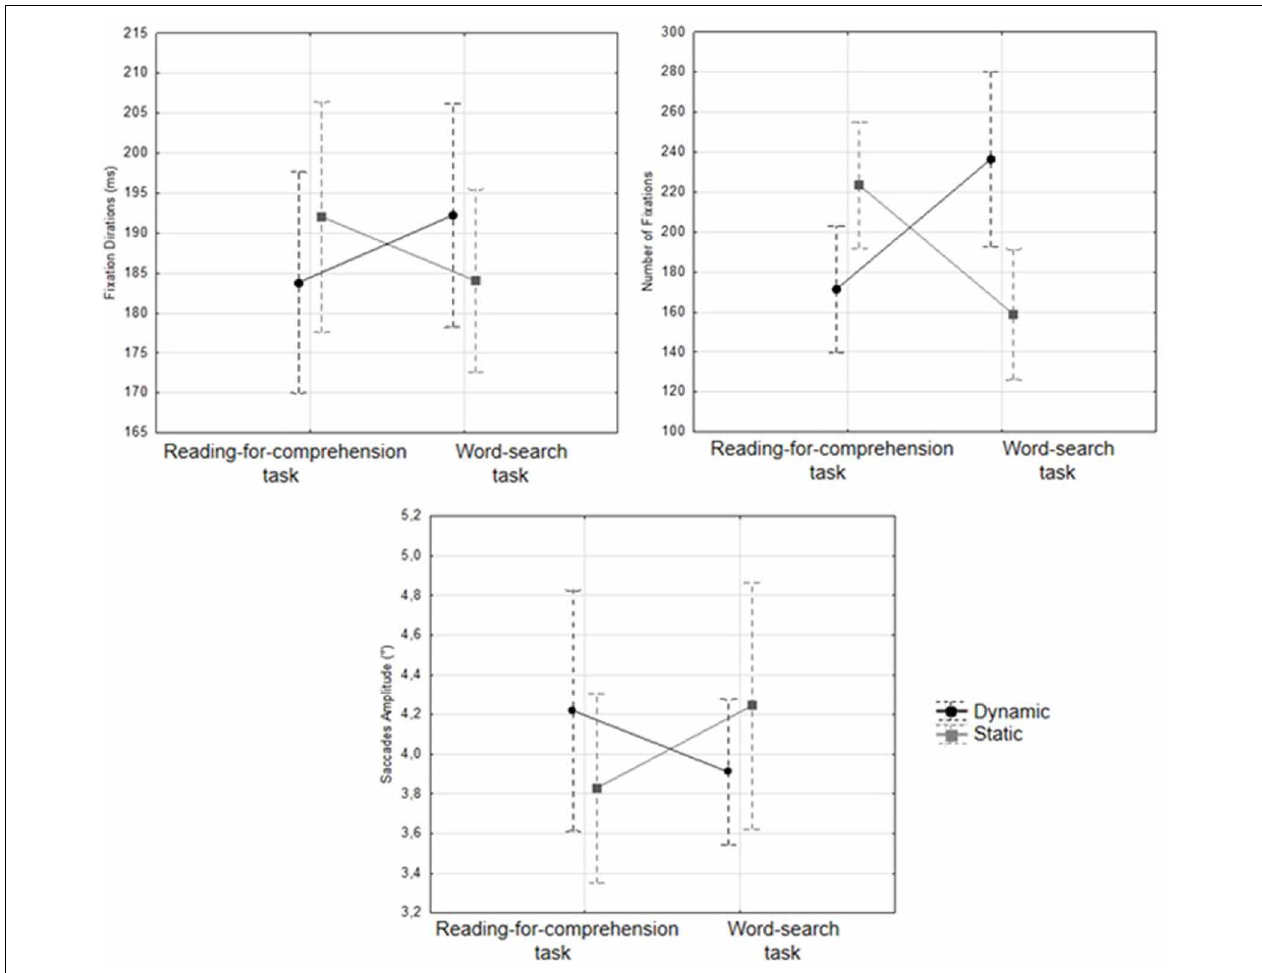
We did not obtain any significant results for the saccade amplitudes of the 13 participants, p = ns